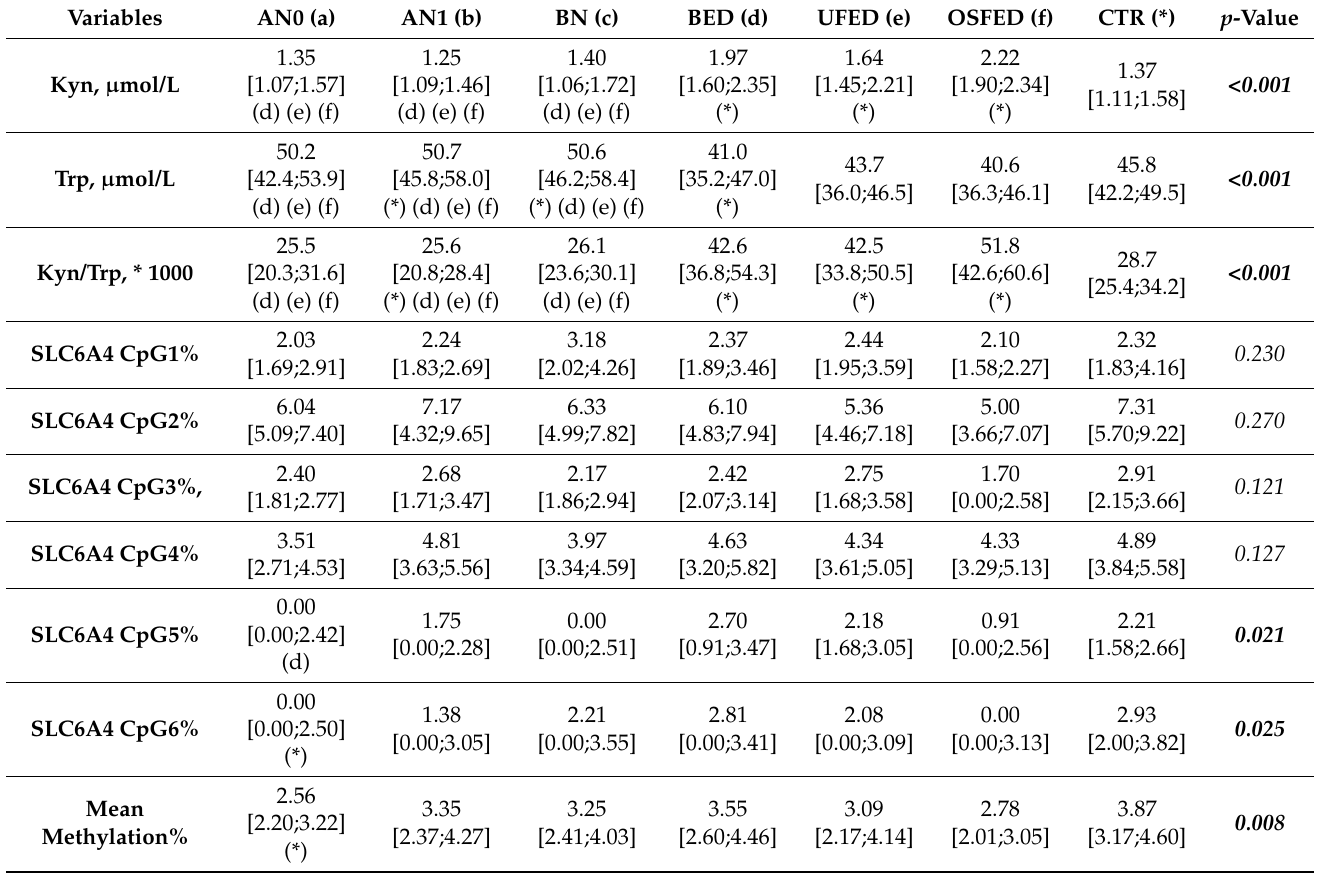
Table 4. DNA methylation levels of the six CpG sites at SLC6A4 in ED groups and controls. Summary descriptive table by groups of diagnosis expressed as median ([q1 = first quartile; q3 = third quartile) for continuous variable and absolute frequency (% = column percentage) for categorical. Significance values are according to the Kruskal–Wallis test. To show the pairwise differences, we assigned a number to each group: AN0 = (a), AN1 = (b), BN = (c), BED = (d), UFED = (e), OSFED = (f) and, CTR = (*). Statistically significant values are in bold. Abbreviations: AN0 = restricting anorexia nervosa; AN1 = purging anorexia nervosa; BN = bulimia; BED = binge eating disorders; UFED = un- specified feeding or eating disorder; OSFED = other specified eating disorders; CTR =